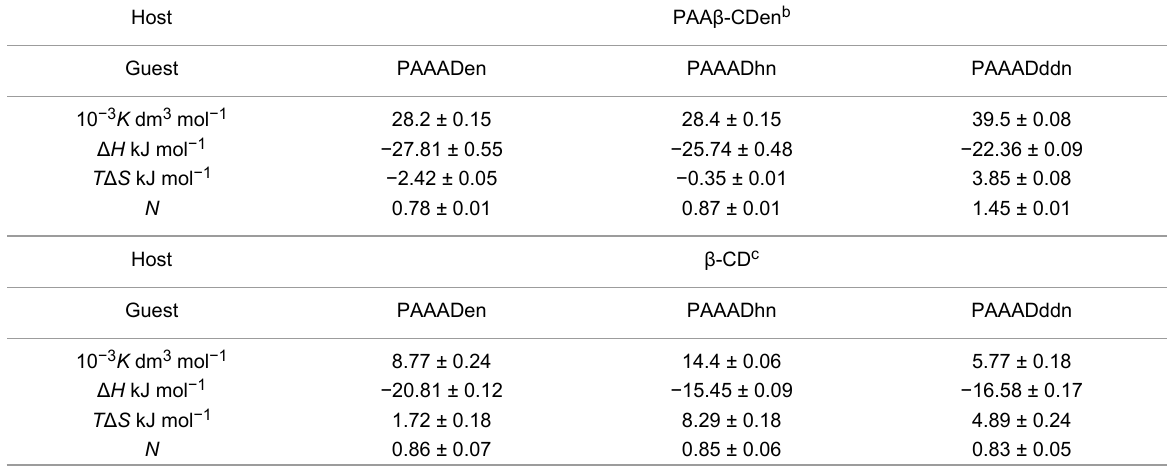
Table 1: Parameters for host–guest complexation between PAA β -CDen and PAAADen, PAAADhn, or PAAADddn.